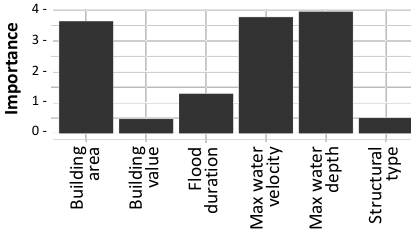
Figure 6. Importance of predictive variables considered in SMV (building area, building value per unit area, flood duration, maxi- mum water velocity, maximum water depth, structural type).